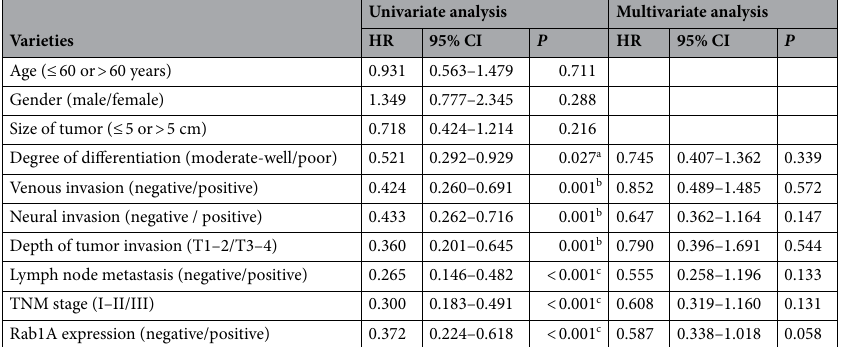
Univariate analysis Multivariate